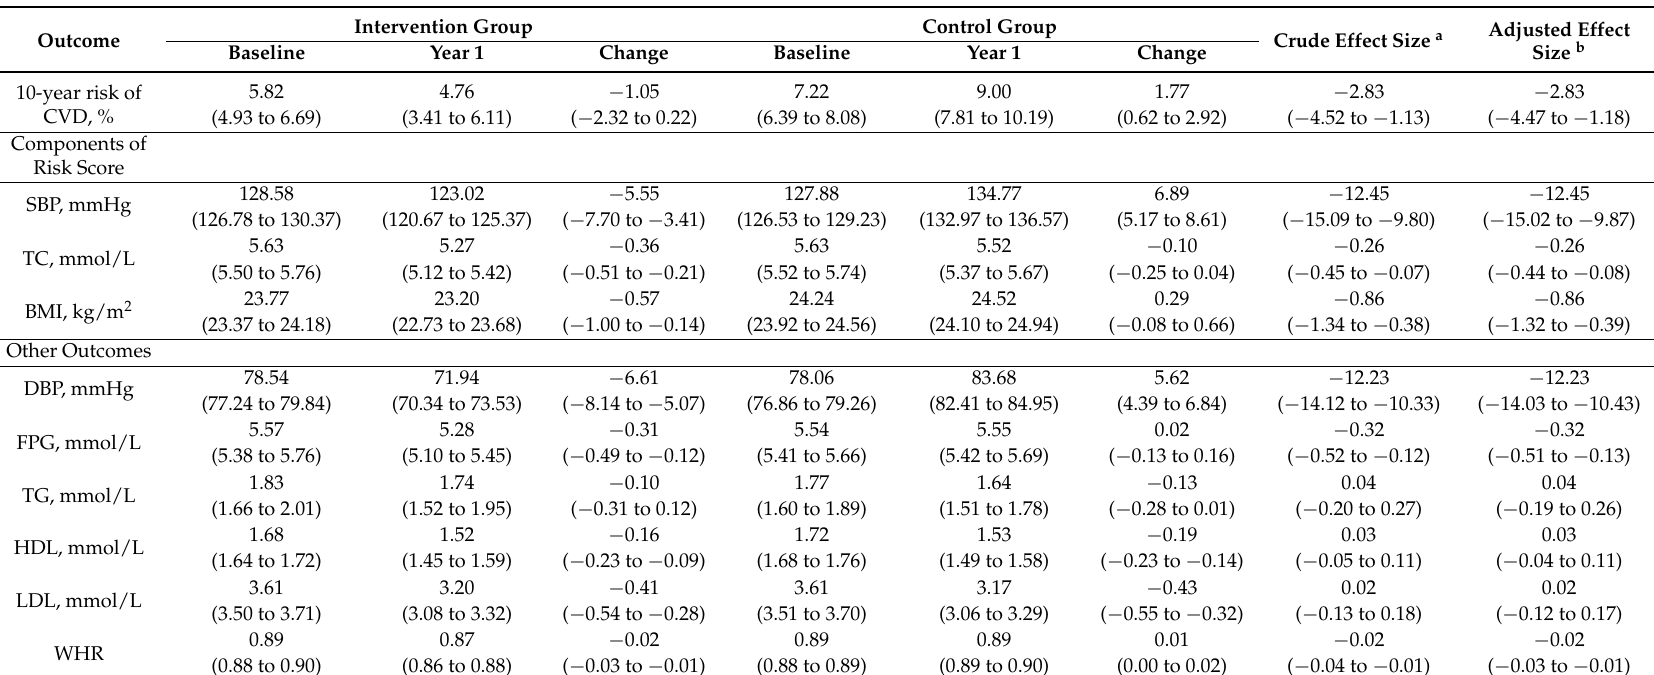
Table 3. Changes in outcomes (Mean